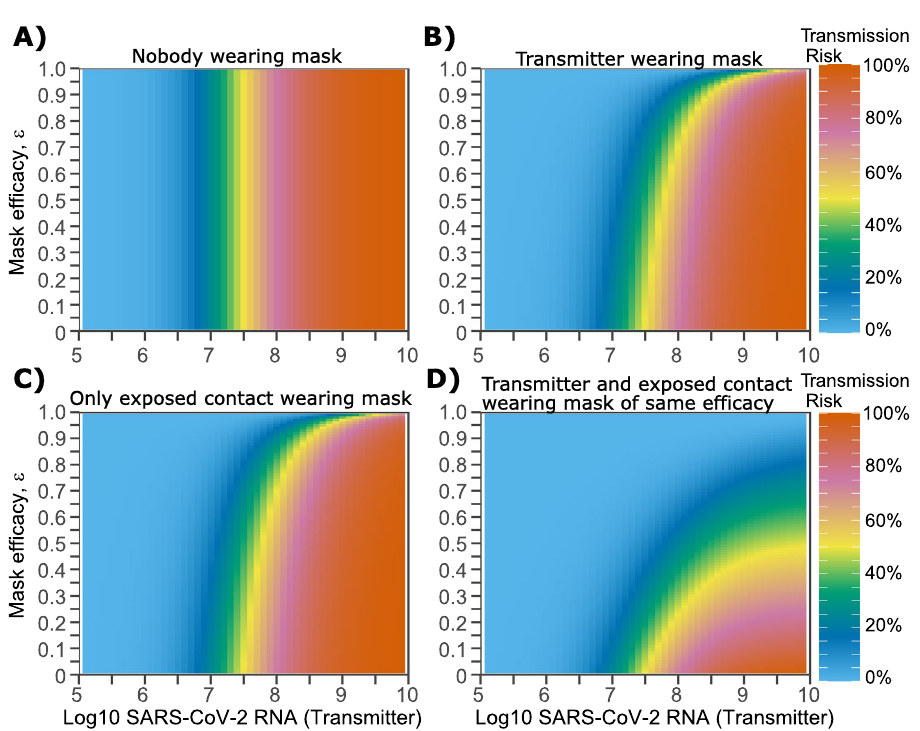
Figure 2. Impact of masking the transmitter alone, the exposed contact alone or both members of the transmission pair, on transmission risk given a single exposure contact. ( A – D ) Each panel is based on simulations of 1000 transmission pairs. ( A ) No masking, ( B ) Transmitter is masked, ( C ) Exposed contact is masked, ( D ) Both members are